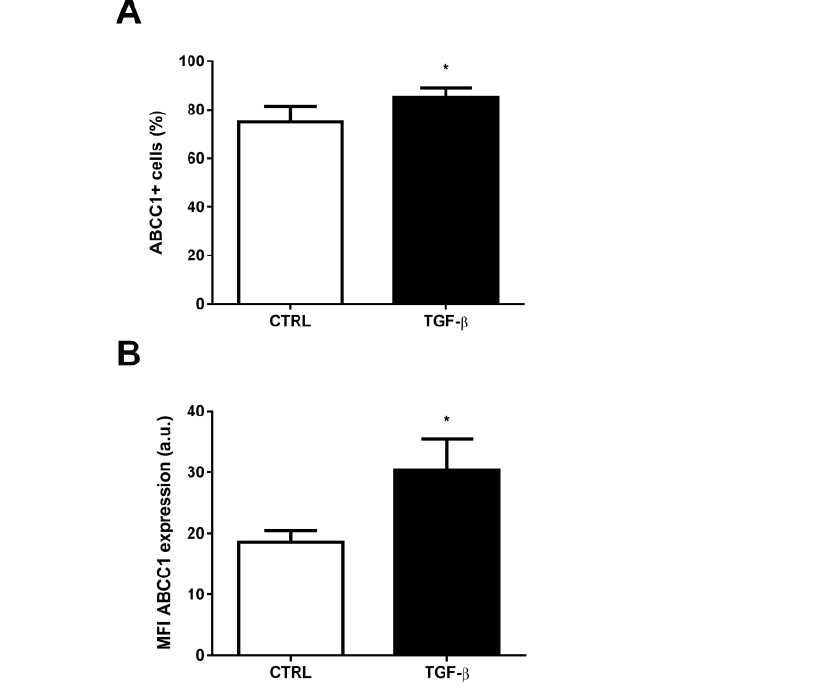
Figure 7. MK-571 changes the expression of epithelial-mesenchymal transition (EMT)-related pro- teins. A549 cells (1 × 10 5 cells/mL) were incubated with 25 µM MK-571 for ABCC1 inhibition in the absence or presence of 5 ng/mL TGF- β for EMT induction. After 48 h, the cells were stained with